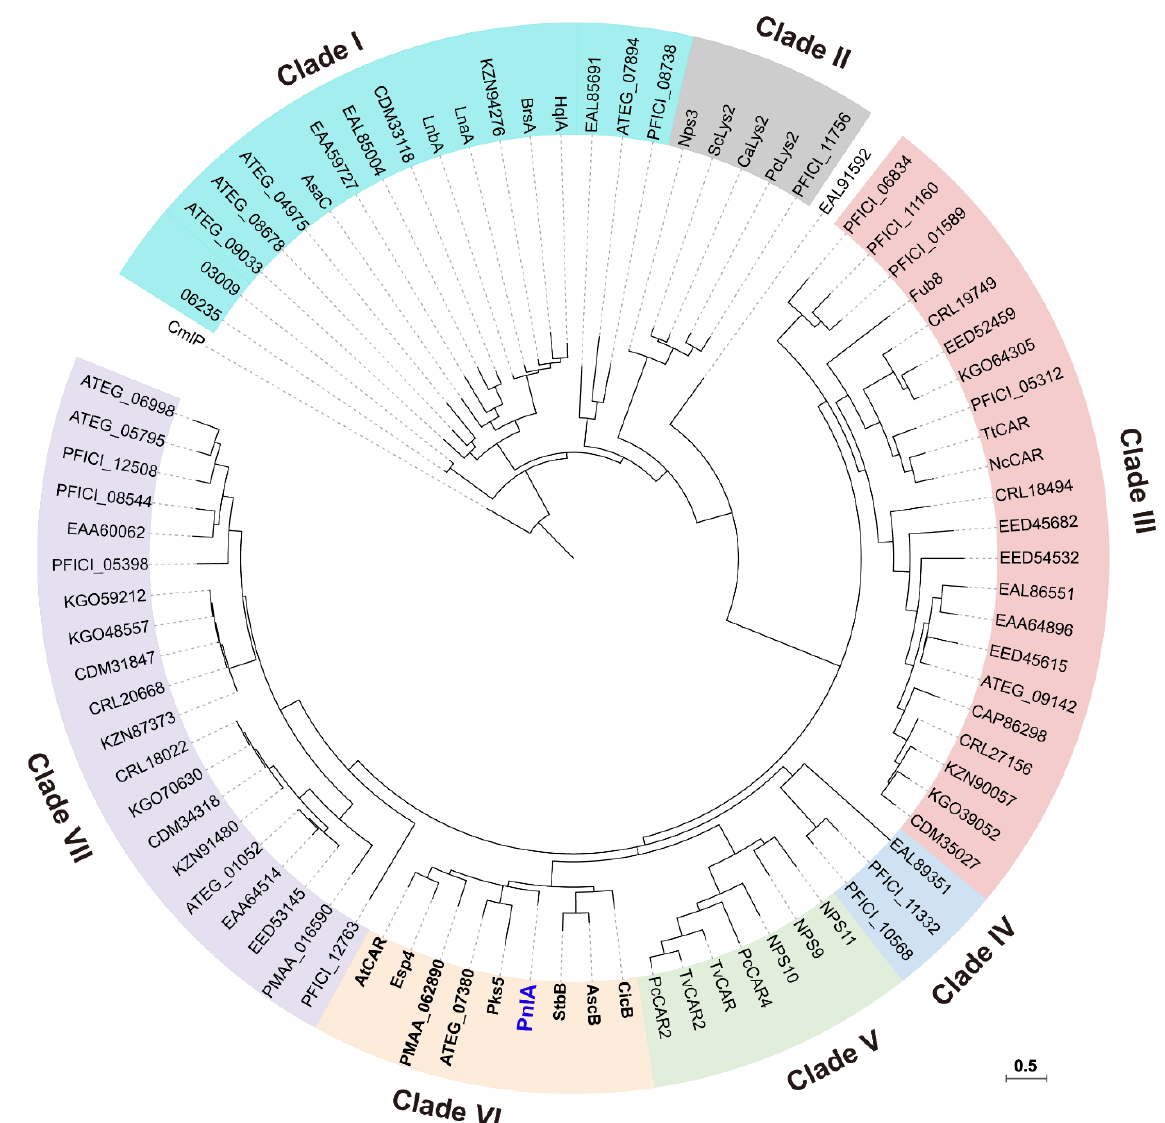
Figure 2. Phylogenetic analysis of 84 CAR protein sequences from fungi. Seven distinct clades are shown in different colors. CARs in clade I, II and VI are mainly responsible for the reduction of amino acids, L -aminoadipate and orsellinic acid derivatives, respectively. CmlP characterized in Streptomyces venezuelae was used as the outgroup to root the tree [38]. Multiple alignments were performed by ClustalW with MEGA 7.0. The phylogenetic tree was constructed based on maximum likelihood (ML) analysis using RAxML 8.2.10 and visualized in iTOL v6. Amino acid sequences were obtained from the GenBank database.